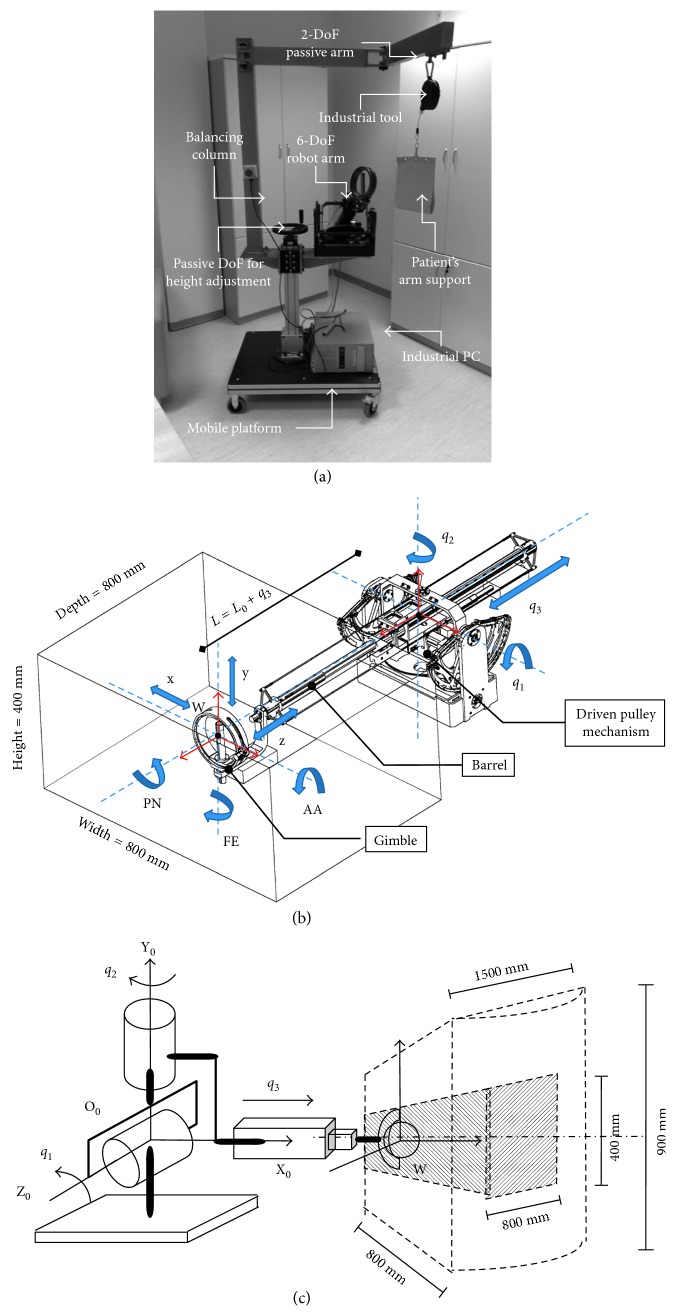
BRANDO rehabilitation robotic system consisting of a 6-DoF robot device mounted on the passive mobile platform, with a passive handle attached at the end-effector. (a) The full final system. (b) The mechanism of the 6-DoF robotic arm. (c) Conical workspace of the robot, with a minimum reachable square workspace of 400 × 800 × 800 mm.